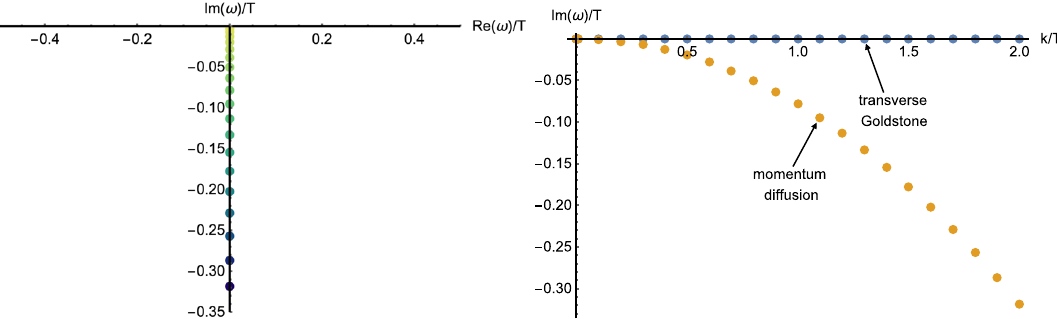
Fig. 1 The motion of the lowest-lying QNMs along the imaginary axis with the increase of k by fixing λ = 0 and J (cid:7)= 0. Left: Imaginary part of the frequency of the QNMs with fixed T /μ = 1 and μ/α = 1, k ∈ [ 0 . 005 , 0 . 1 ] (yellow to blue). Right: Imaginary parts of the frequency as functions of k /